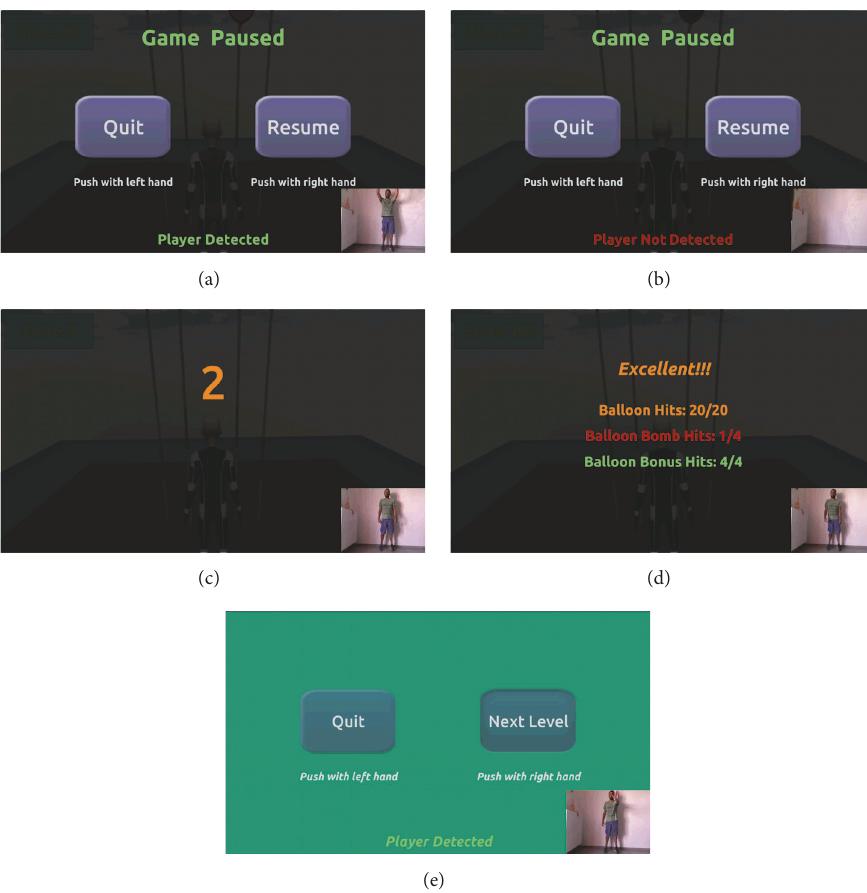
Figure 8: (a) Player executes a “Stretch Arms High” gesture to pause the game, after which he decides to leave the room; (b) as a result of moving off the FOV of the Kinect sensor, the player appears as “not detected”; (c) a countdown counter appears on-screen after the player has returned and opted to continue the game; (d) at the end of a game, game-specific performance data is shown to the player; (e) the player can now opt to quit the game or proceed to the next game